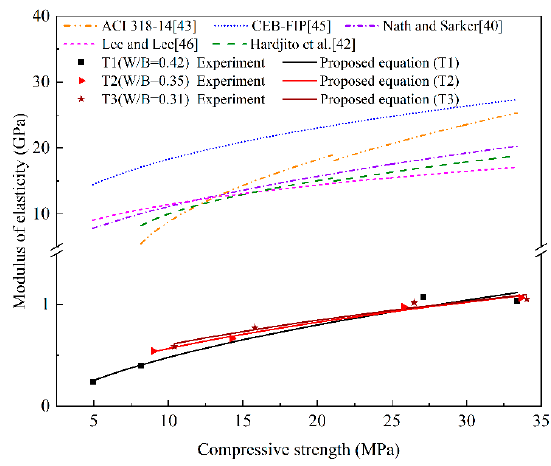
Figure 10. Comparison of tested and predicted results. Table 4. Equation Parameters of the empirical Model.